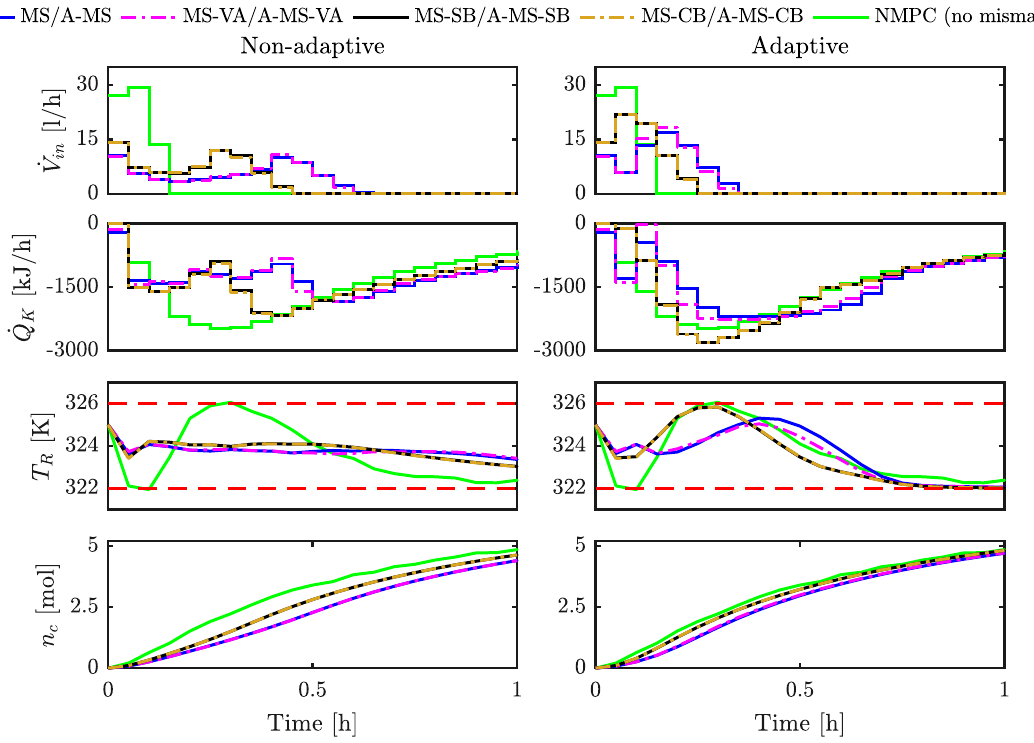
Figure 5. Input feed, jacket cooling power, reactor temperature, and moles of product C obtained using different NMPC strategies in the presence of measurement noise. Left figure: The plant is controlled using the non-adaptive approaches explained in Section 3, Right figure: The plant is controlled using the adaptive approaches explained in Section 4. The true plant parameters are assumed to be the nominal parameters. NMPC (no mismatch)—the plant model and the simulation model are identical.